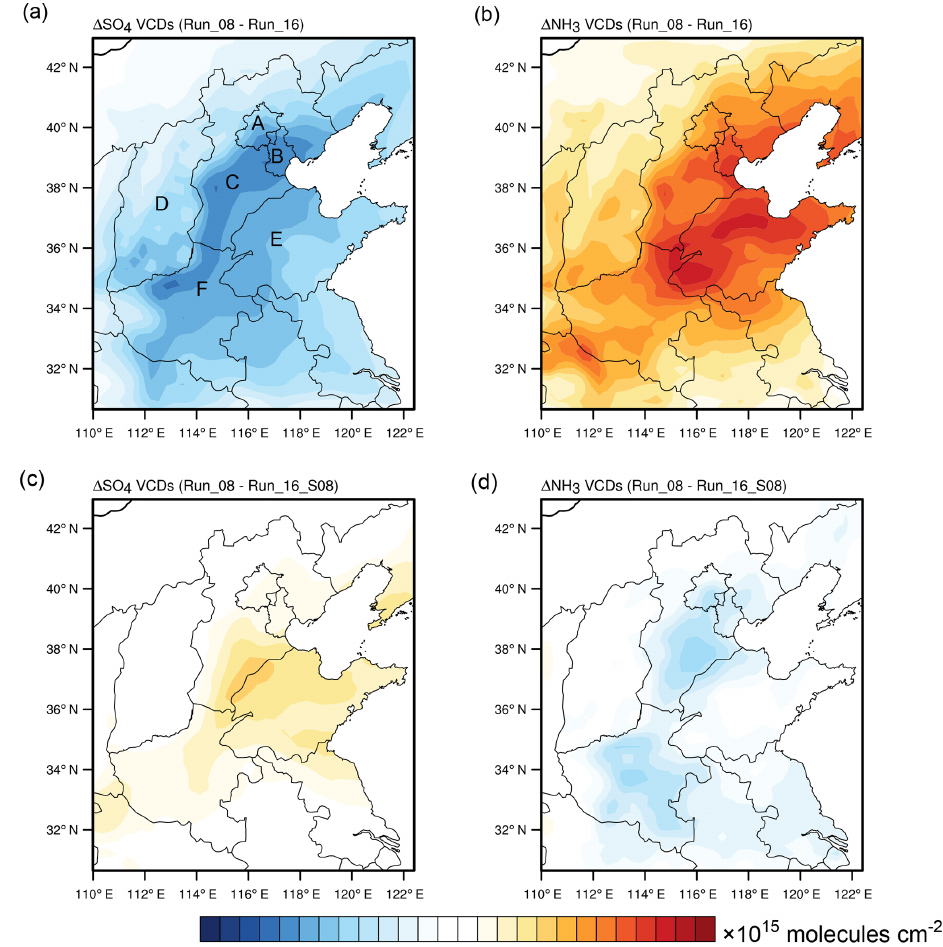
Figure 5. The differences between Run_08 and Run_16 (a, b) , and between Run_08 and Run_16_S08 (c, d) . A–F in a denote the Beijing, Tianjin, Hebei, Shanxi, Shandong, and Henan Provinces, respectively.